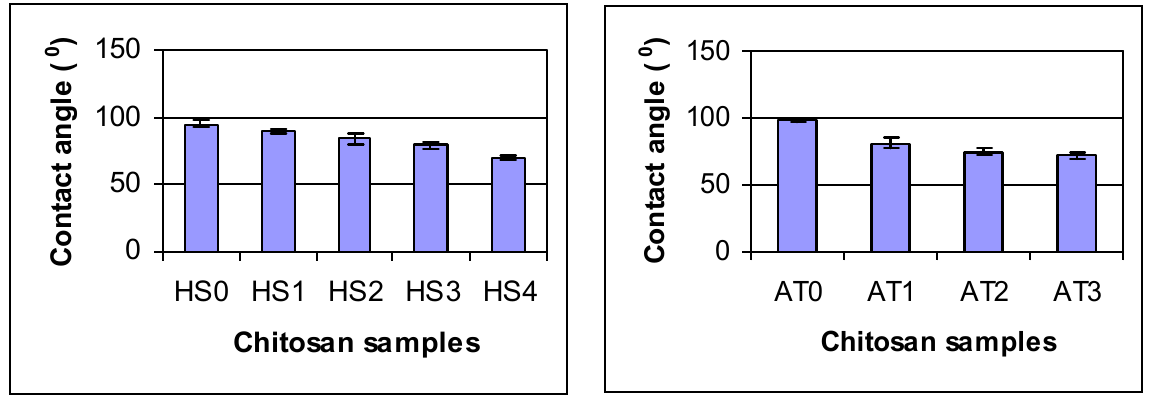
Figure 3. Contact angle of deacetylated chitosan. Statistics analysis shows by 2 Factor ANOVA: there are differences due to chitosan type (p = 0.0042) and processing time (p = 0.001). For Agratech chitosans: AT0 is different from all others, AT1 is different from all others, AT2 and AT3 are the same (p < 0.05). For HS chitosan: all groups are different except HS2 and HS3 are the same (p < 0.05). All comparisons made by Tukey’s HSD